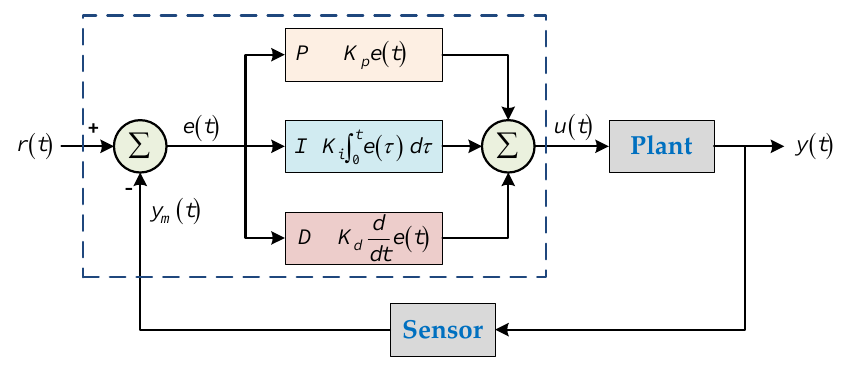
Figure 10. Block diagram of the PID controller.